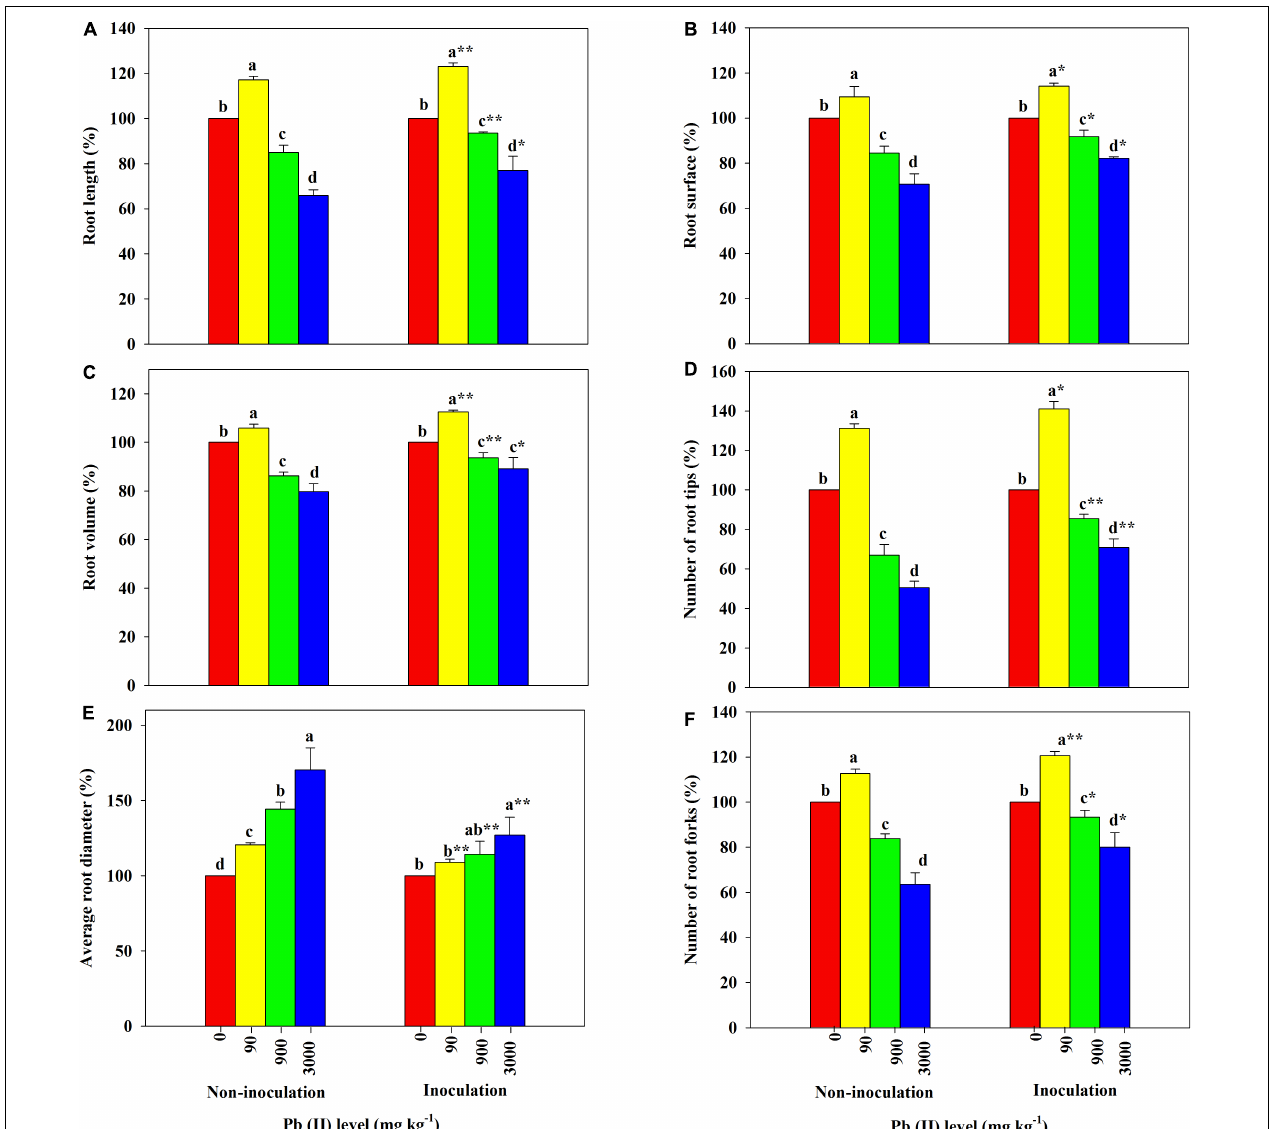
FIGURE 4 | Relative changes in root morphology of Robinia pseudoacacia grown with or without Funneliformis mosseae and subjected to different Pb levels for 4 months. (A) Root length. (B) Root surface area. (C) Root volume. (D) Number of root tips. (E) Average root diameter. (F) Number of root forks. Shown are means ± SD ( n = 3). Asterisks indicate significant differences between inoculated and non-inoculated seedlings within each Pb treatment ( ∗ P < 0.05, ∗∗ P < 0.01; t -test). Different lowercase letters indicate significant differences among different Pb levels within inoculated or non-inoculated treatment ( P < 0.05; ANOVA with post hoc